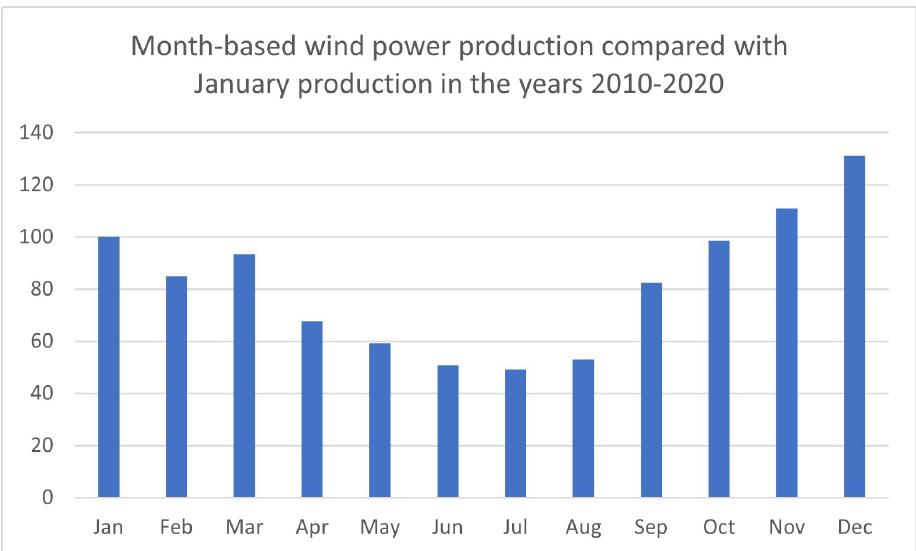
Figure 9. Monthly wind power production in Norway from January 2010 to January 2021. Based on figures from Statistics